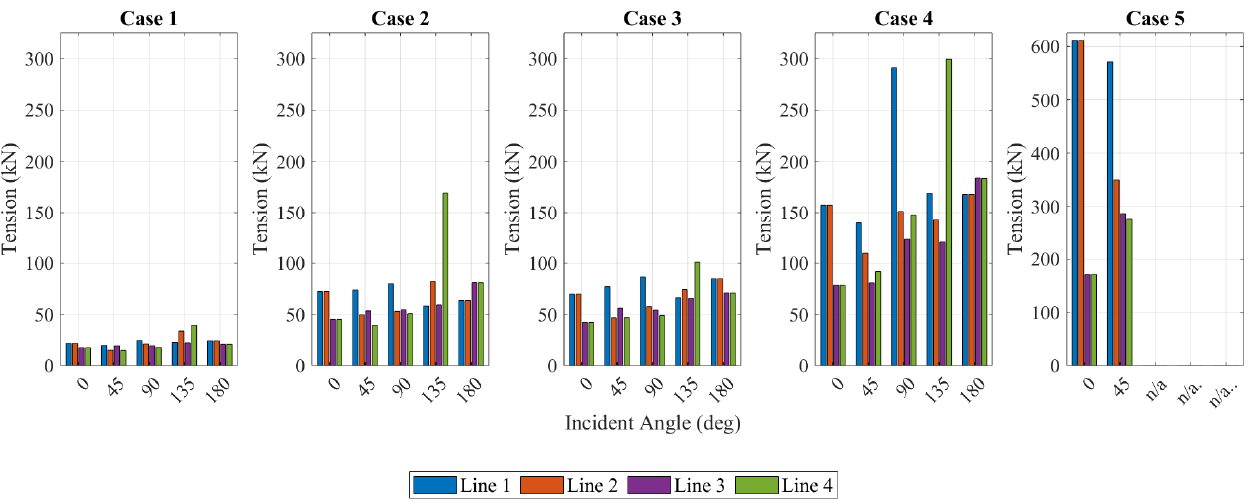
Figure 13. Mean tensions (kN) in mooring lines for Cases 1–5 over a 3 h storm duration and under varied incident wave directions and sea states.